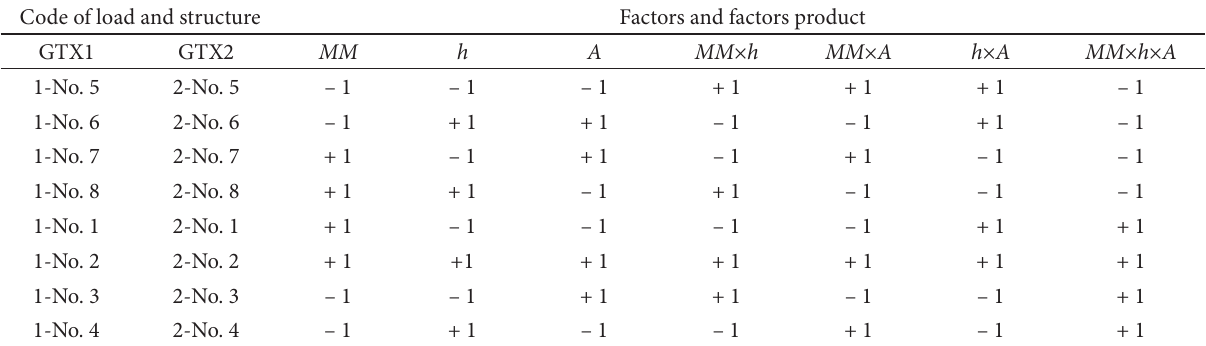
Table 2. The matrix of a full factorial experiment Code of load and